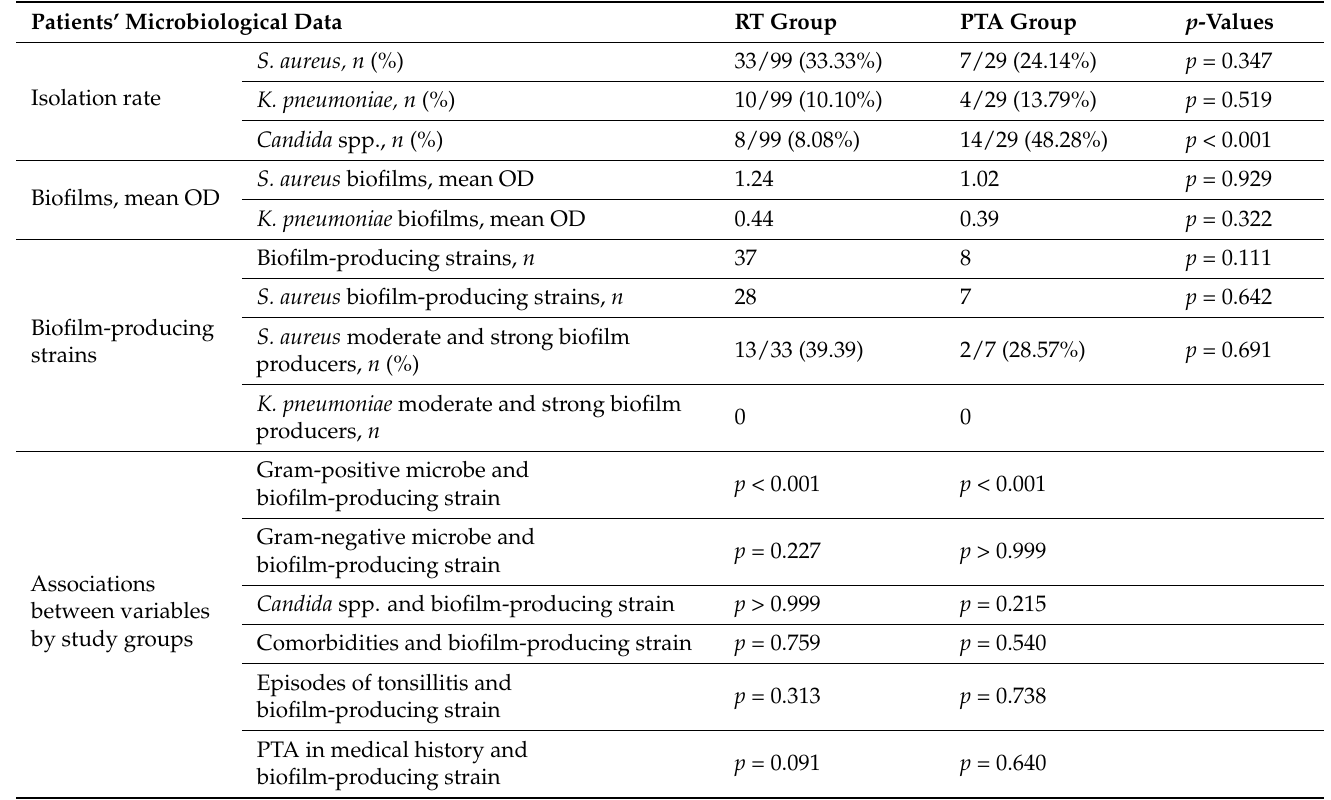
Table 2. Comparison of patients’ microbiological data in the RT and PTA